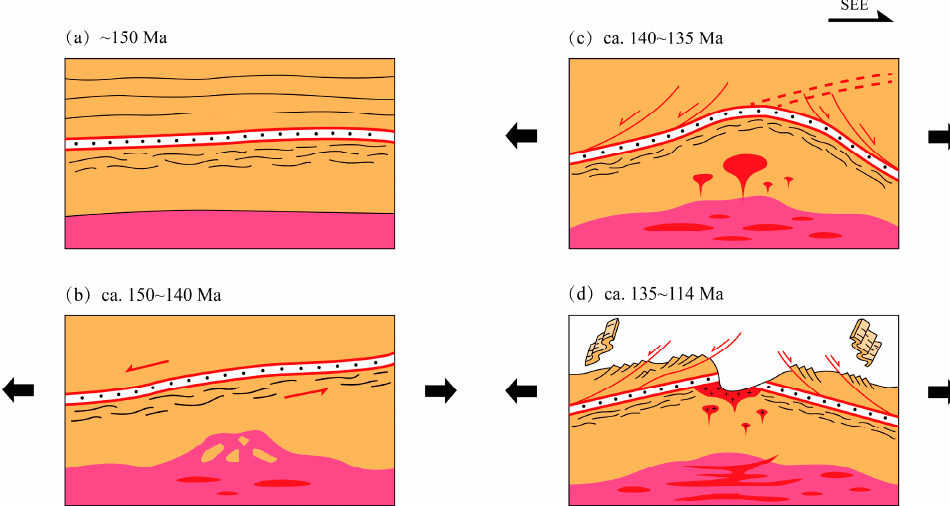
Figure 12. Structural evolution diagram of extensional stage.